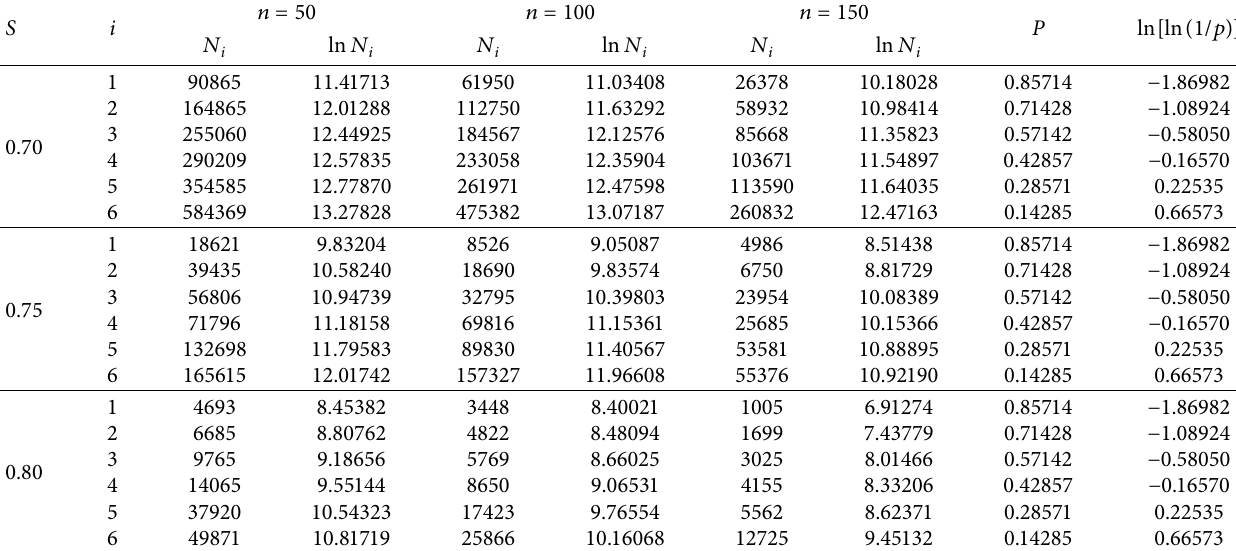
Table 7: Two-parameter Weibull distribution test of the fatigue life of frost-damaged AASC.